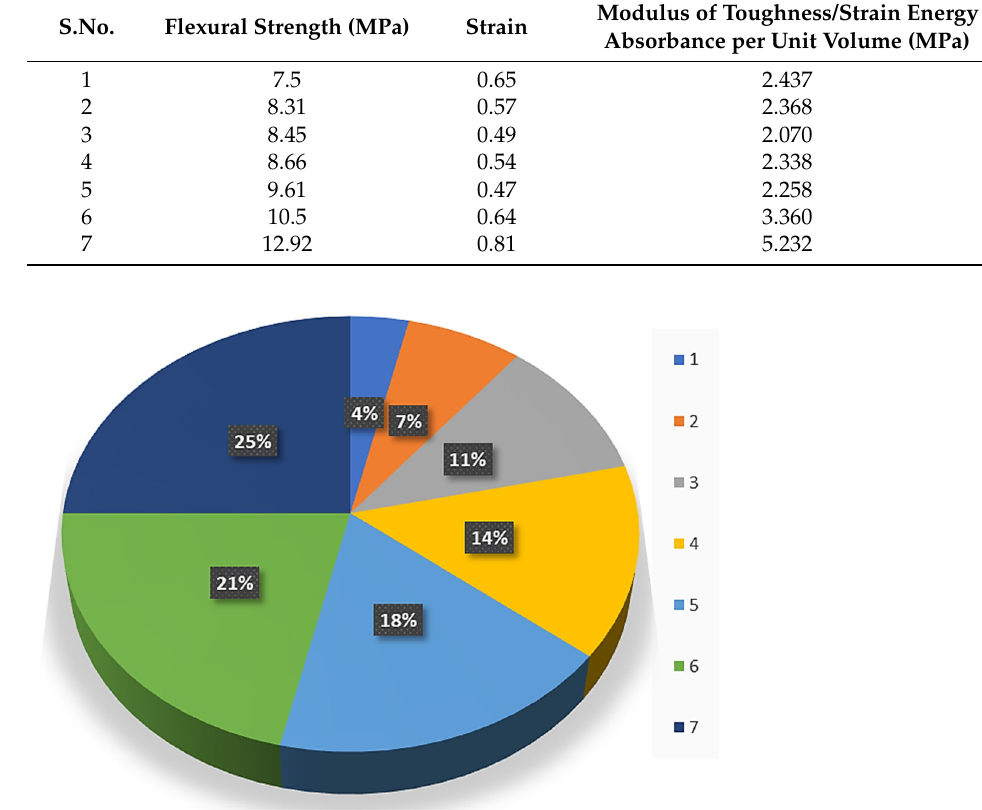
Table 7. Strain energy is absorbed by ATA specimens (area under the curve for stress vs. strain).